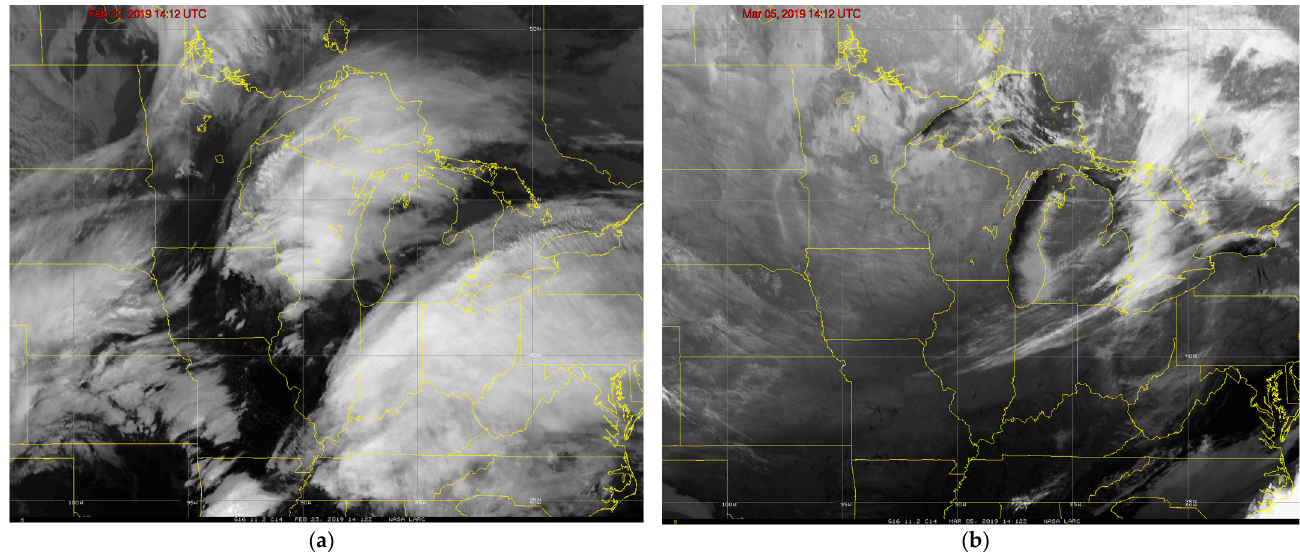
Figure 3. GOES-16, 11.2 µm infrared satellite imagery of representative time windows, in the middle of the flights. ( a ) F20, ( b ) F28. The images were obtained from the Satellite Cloud and Radiation Property retrieval System (SatCORPS) Team, http://satcorps.larc.nasa.gov (accessed on 1 January 2021).